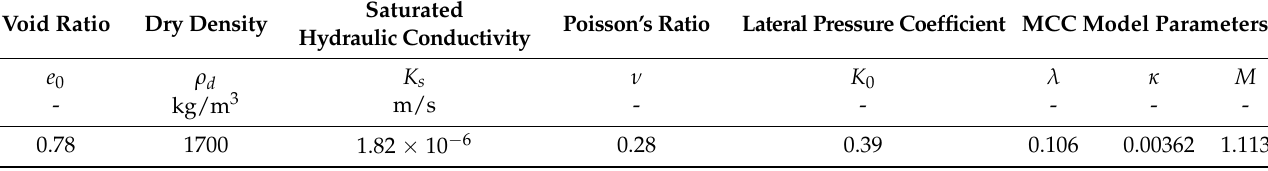
Table 2. The mechanical parameters of the retaining structure of the excavation. Retaining Structure